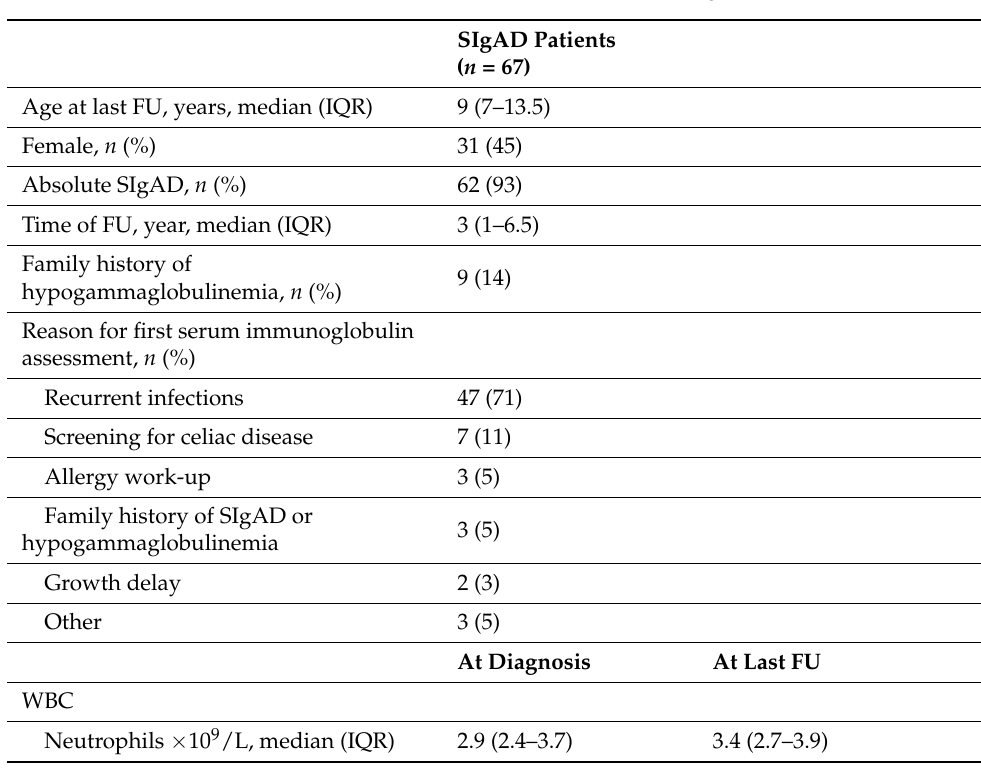
Table 1. Characteristics of 67 enrolled children and adolescents with